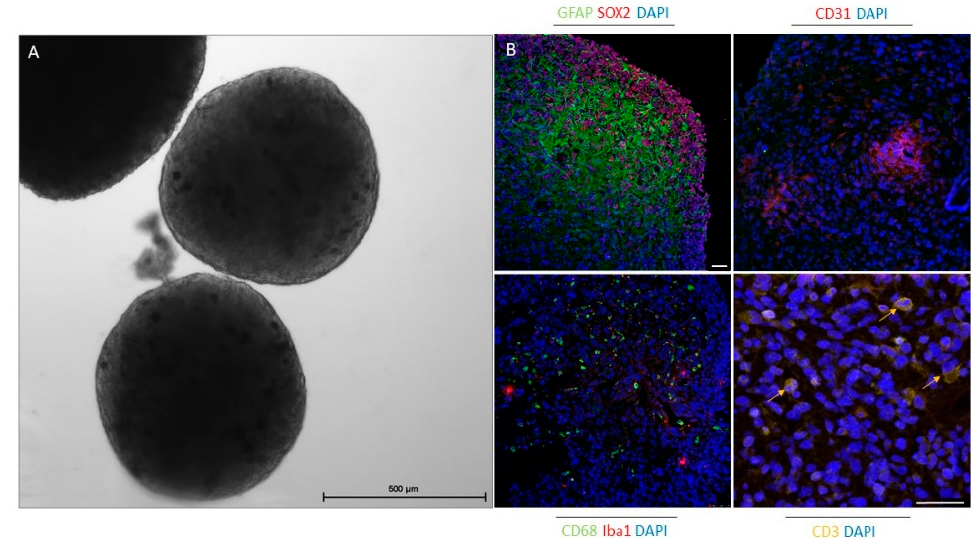
Figure 2. Glioblastoma organoids after 4 weeks in culture preserve specific elements of the tumor microenvironment. ( A ) Phase-contrast image of glioblastoma organoids in culture. Scale bar: 500 µm. ( B ) Immunofluorescence staining of paraffin-embedded glioblastoma organoids for glioblastoma stem cell marker (SOX2), differentiated glioblastoma cell and astrocyte marker (GFAP), endothelial cell marker (CD31), macrophage marker (CD68), microglia marker (Iba1), and T cell marker (CD3). Cell nuclei were stained with DAPl (blue). Scale bars: 50 µm.